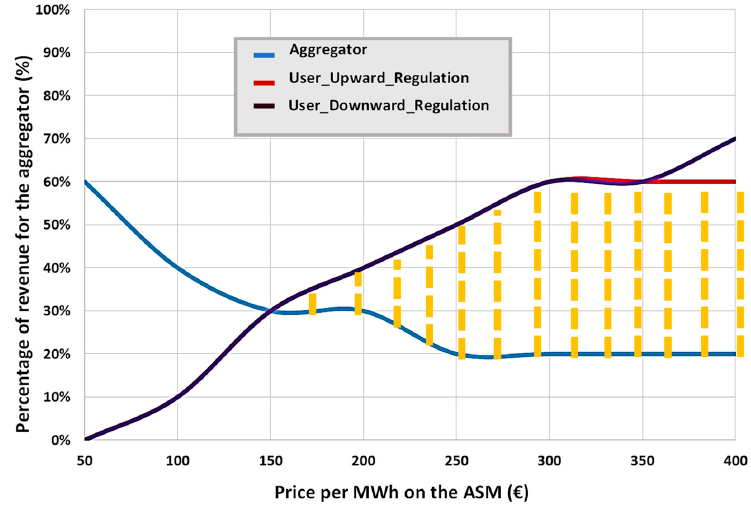
Figure 15. Aggregator-users profit area for 2000 MWh of energy exchanged (EMP costs = 0 and COM costs = 0).